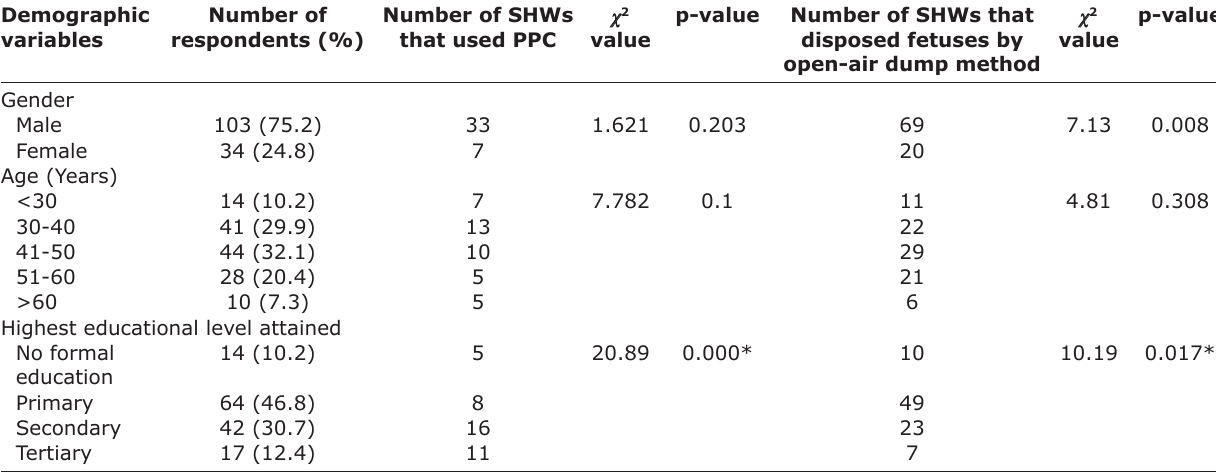
Table-6: Association between slaughterhouse practices and demographics and educational levels of SHWs (n=137) surveyed in Enugu State, Nigeria. Demographic variables